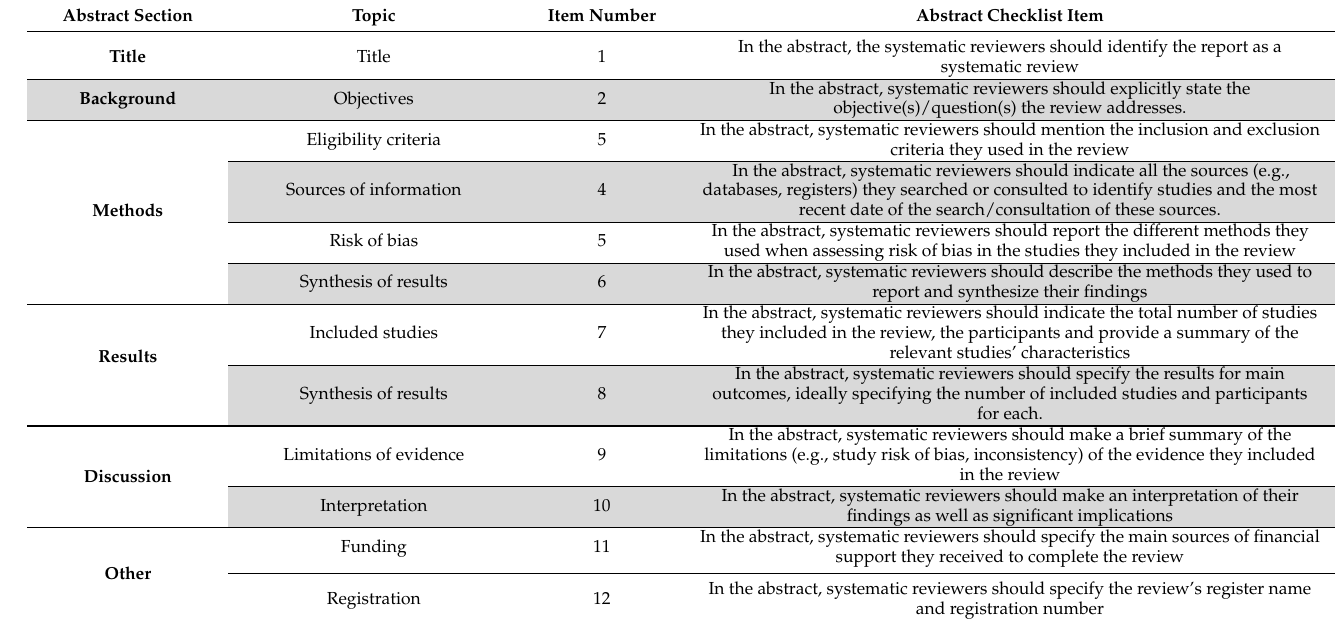
Table A1. PRISMA 2020 12-item checklist for abstracts adapted from [2,4].